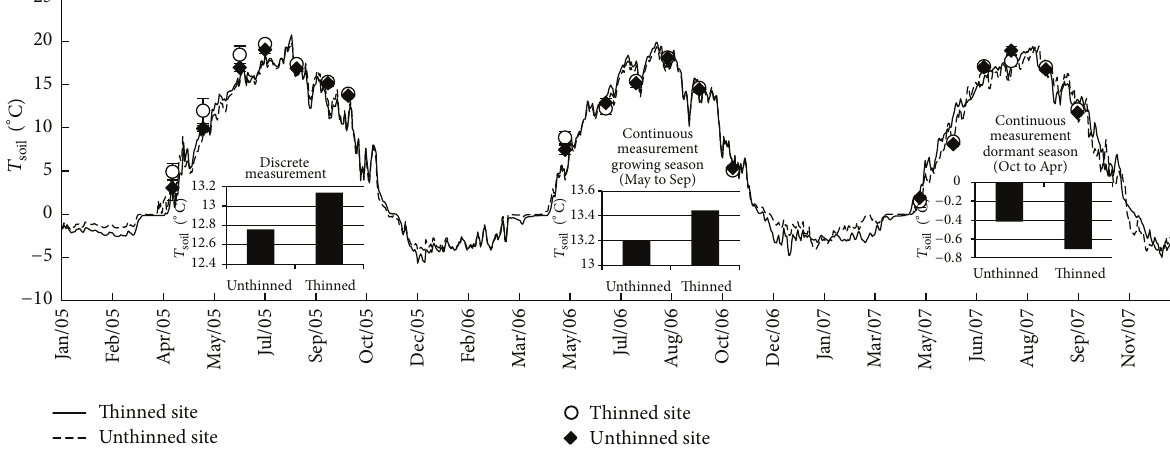
Figure 2: Differences in soil temperature (daily mean value) between thinned and unthinned sites. Line data were the daily mean values of continuously recorded temperatures measured using an RT21s thermometer, while the scattered data were discrete measurements that were taken at the same time as soil respiration was